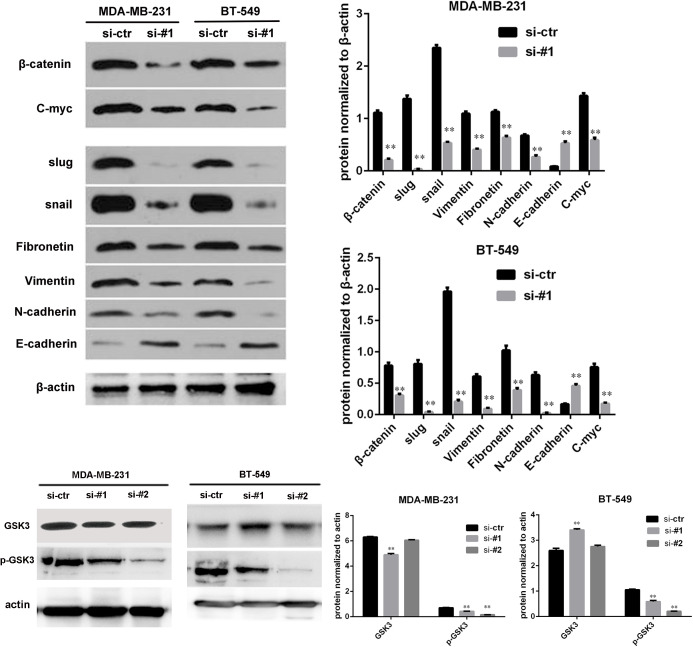
AFAP1-AS1 knockdown reduced the expression of C-myc and EMT-related molecules through Wnt/β-catenin signaling pathway. The expressions of β-catenin, GSK3, p-GSK3, C-myc, SLUG, SNAIL, vimentin, fibronectin, N-cadherin, and E-cadherin in MDA-MB 231 and BT-549 cells detected by Western blot. β-actin was used as the loading control. AFAP1-AS1 knockdown significantly decreased the expression of β-catenin, p-GSK3, C-myc, and EMT-related molecules (SLUG, SNAIL, vimentin, fibronectin, and N-cadherin), but increased the expression of E-cadherin in both MDA-MB-231 and BT549 cells (∗∗P < 0.01).